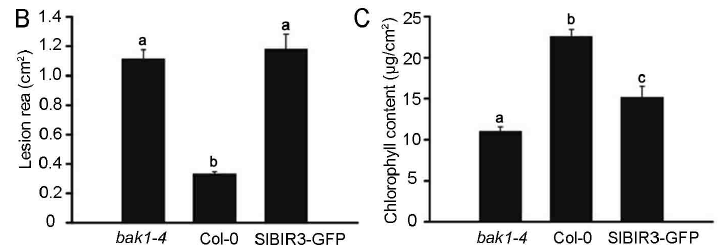
Figure 6. Heterologous expression of SlBIR3 in A. thaliana suppresses resistance to B. cinerea ( A ) Disease phenotypes of bak1-4 , Col-0 (wild type) and SlBIR3-overexpression plants (all Col-0 background) after spraying with a B. cinerea spore suspension, 7 days after the inoculation. The upper panel shows the whole plants and the lower panel shows detached leaves. ( B ) The lesion areas in plants shown in ( A ). The average lesion areas of 10 leaves were determined. ( C ) The total chlorophyll contents of leaves from the plants shown in ( A ). Chlorophyll was extracted from 10 rosette leaves infected by B. cinerea corresponding to leaves shown in ( A ). Data represent mean values ± SD. Significant differences are indicated by different letters according to a Student’s t test ( p < 0.05). Experiments were performed three times with similar results.